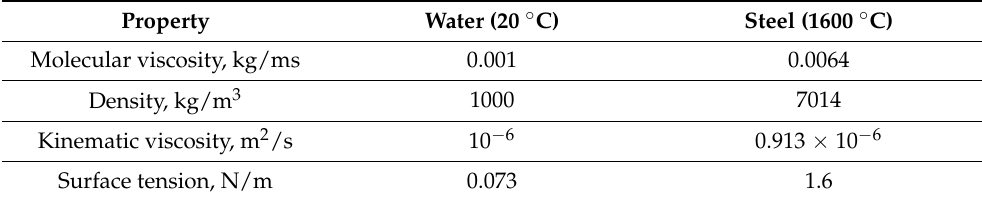
Table 1. Physical property of water and steel at 20 ◦ C and 1600 ◦ C,